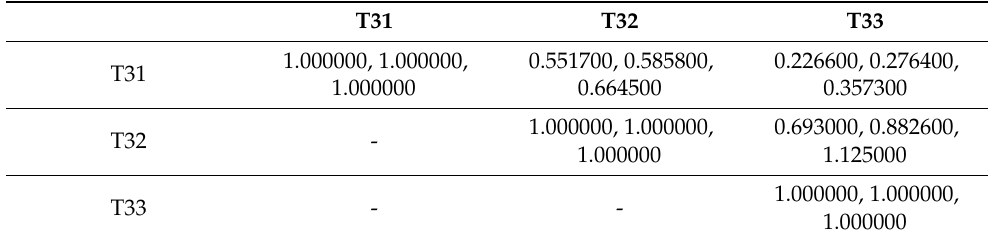
Table 4. Fuzzy aggregated pair-wise comparison matrix at level 2 for Attack Type.